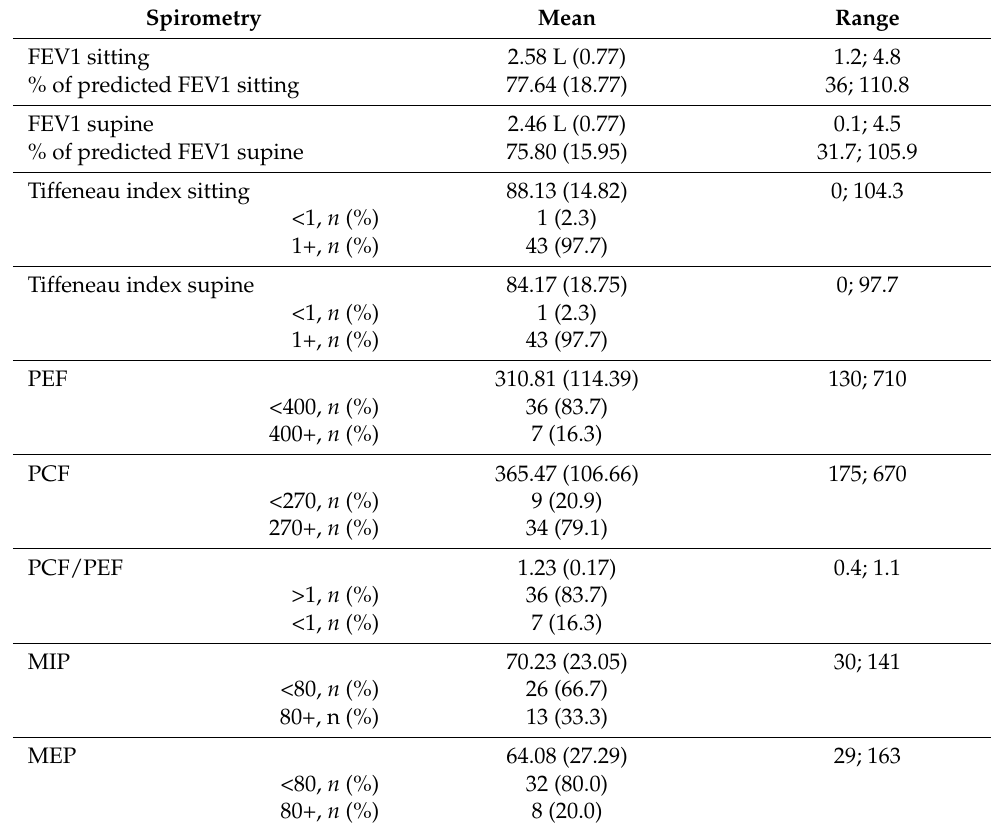
Table 2. Spirometry results: FEV1 sitting and supine, Tiffeneau index and PEF (peak expiratory flow), PCF (peak cough flow), MIP (maximal inspiratory pressure), and MEP (maximal expiratory pressure) values. The study population was subdivided in subjects above and below a cut-off value indicating healthy individuals. Spirometry Mean Range FEV1 sitting 2.58 L (0.77) 1.2;